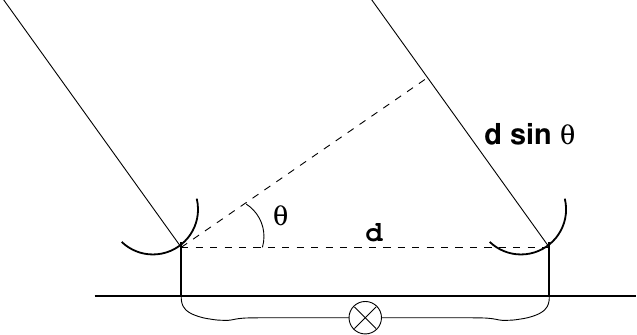
Figure 8. Radio antennae receiving signals from a distant source. The distance d between the antennae, and the angle of incidence θ (from the vertical) cause a differential distance of dsin θ between the parts of coherent waves arriving at the two